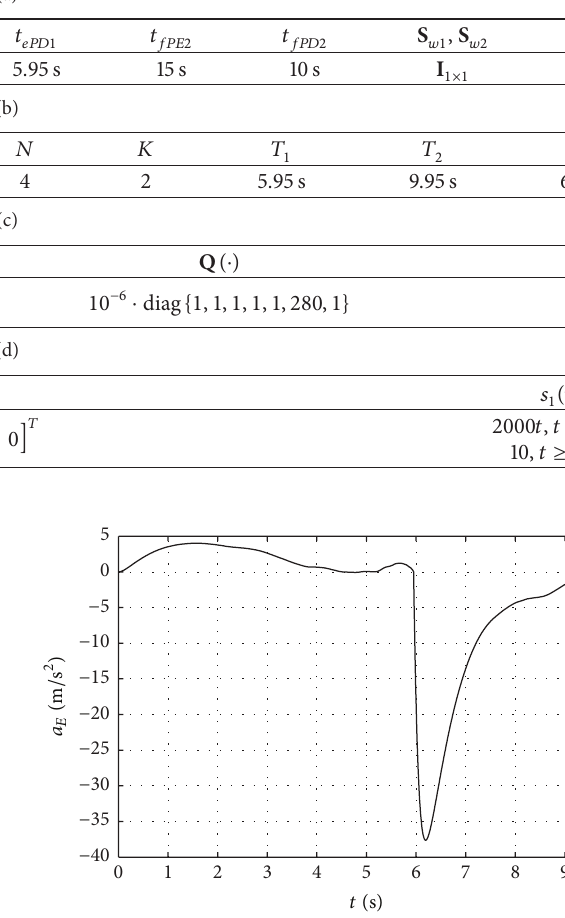
Figure 18: The Evader’s